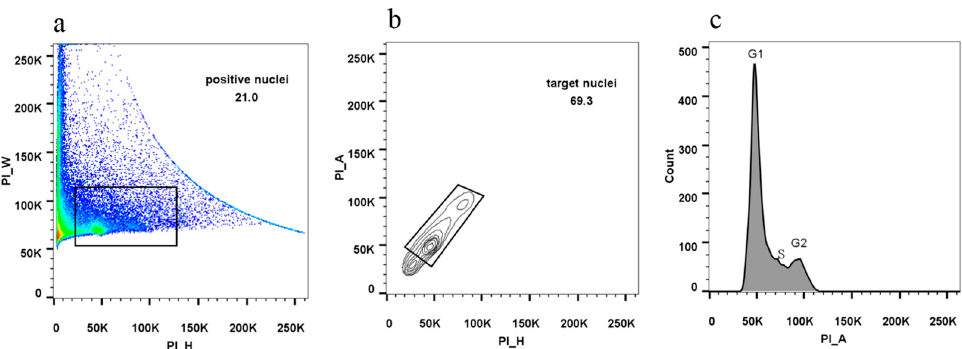
Figure 7. An example of cell cycle study using litchi bud nuclei. ( a ) Dot plot of positive nuclei se- lected by PI-height versus PI-width. ( b ) Contour plot of nuclei from positive nuclei selected by PI-height versus PI-area. b plot produce based on the positive nuclei (rectangular part of a plot). ( c ) Histogram plot of different cell division cycles collected by PI-area. c plot produces from the target nuclei (rectangular part of b plot).